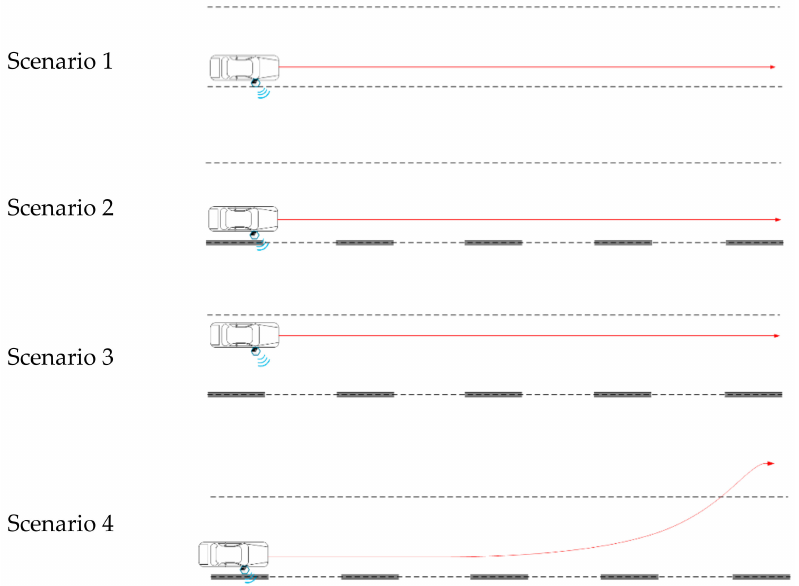
Figure 6. Experiment